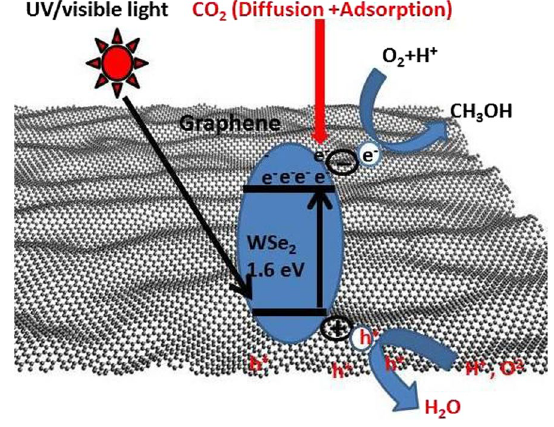
Figure 9. Mechanism study of photocatalytic reduction of CO 2